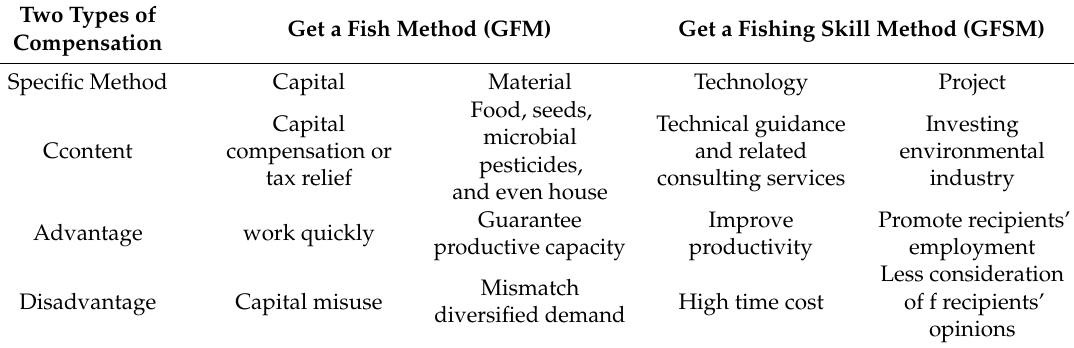
Table 1. Characteristics of GFM and